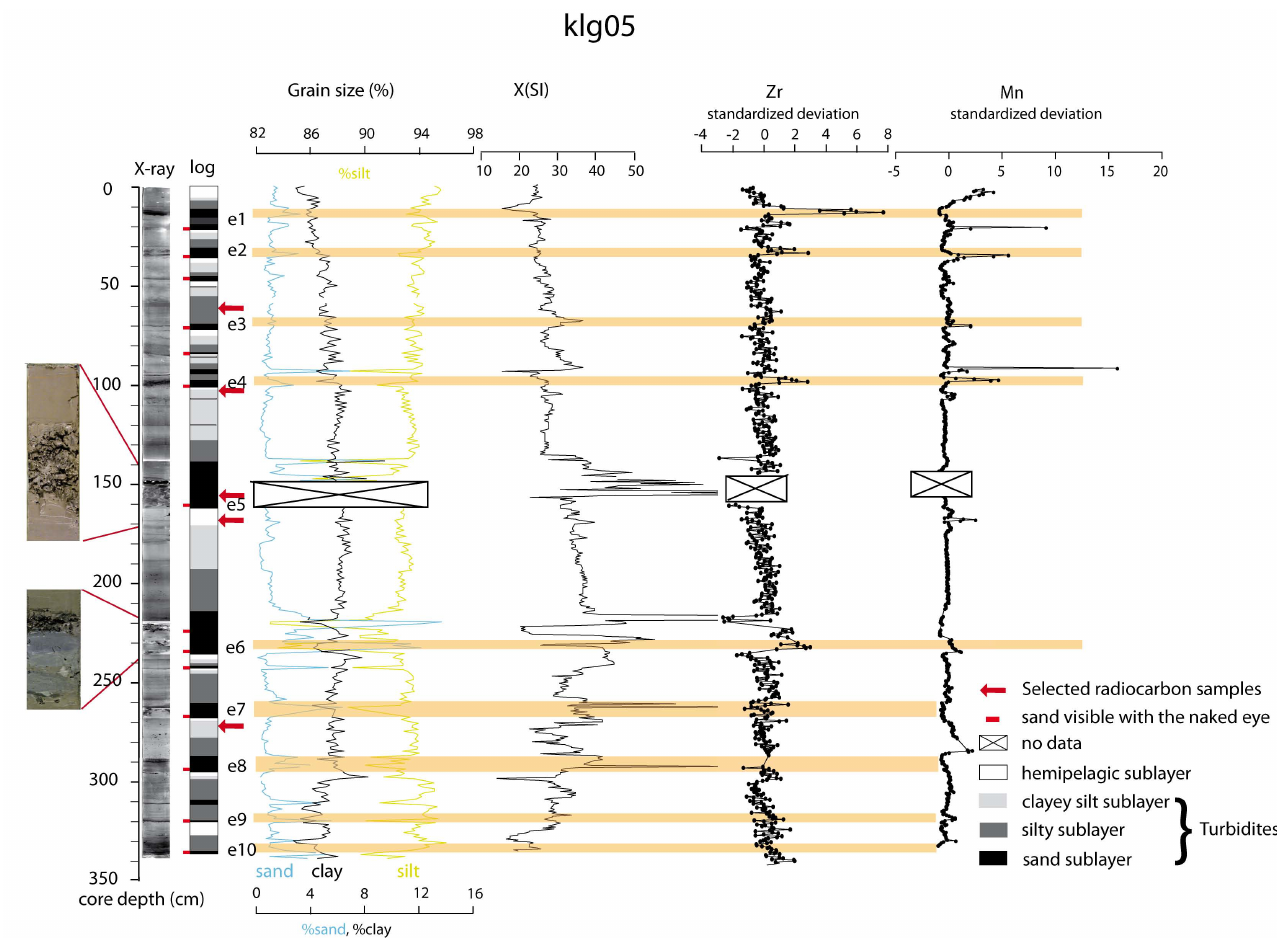
Fig. 4. Stratigraphic log of the Klg05 core in the Tekirda˘g Basin obtained by combining X-ray imagery, grain size, magnetic susceptibility data, Mn and Zr standardized intensities. On the left, zoom pictures of the two basal layers of the thickest turbidites with gravel are presented. Main deposited turbidites are identified and labelled; event labels change according to their stratigraphic position, beginning with 1 at the top of the core. Sandy sublayers are depicted in black, intermediate silty sublayers in grey, upper clay-rich sublayer in light grey and background sedimentation in